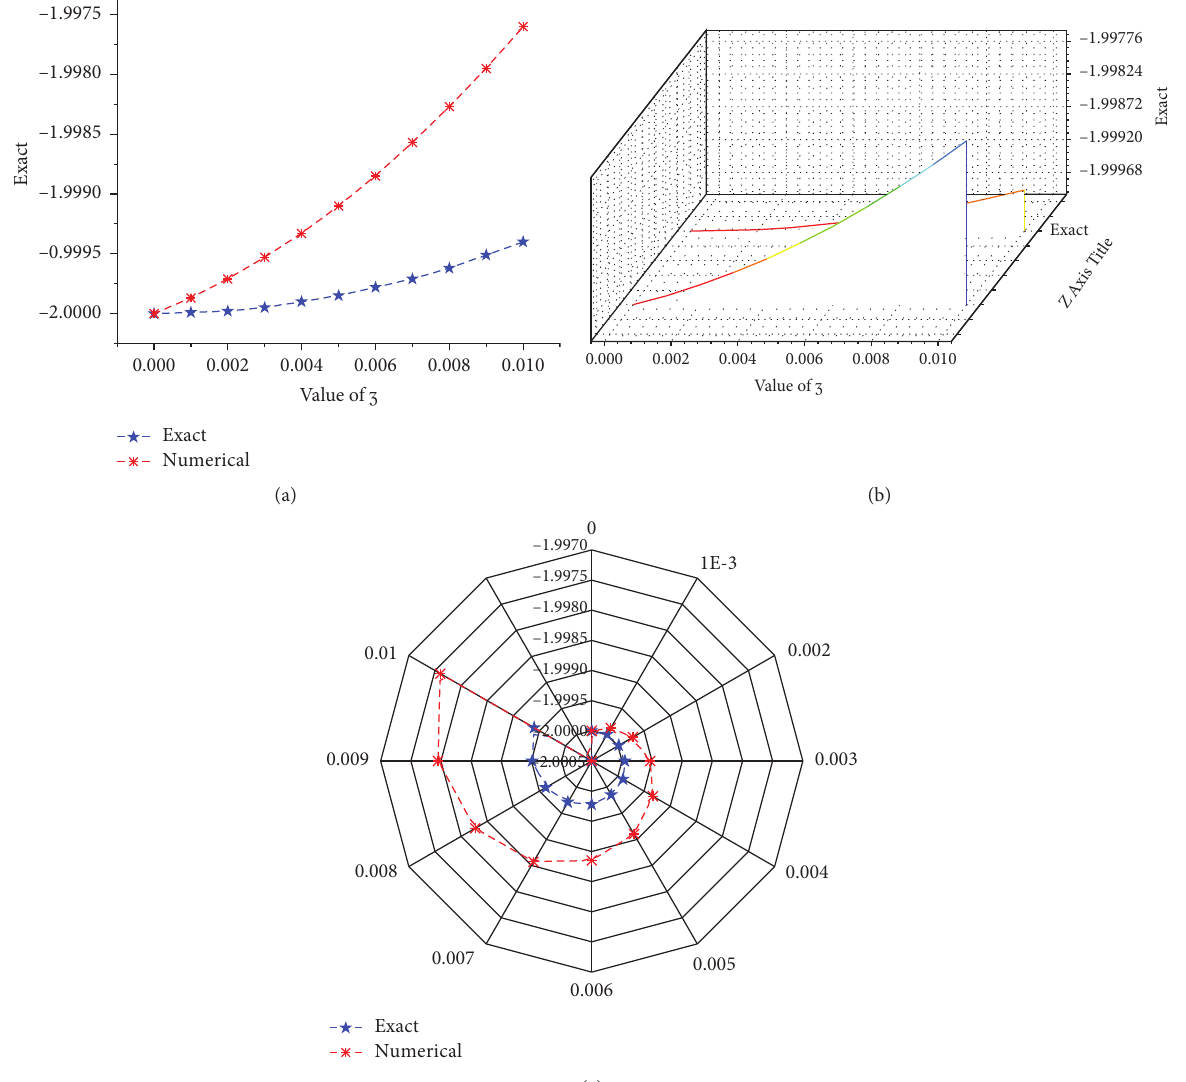
solutions via the extended simplest equation method where the absolute values of error in the sech-tanh method is smaller that those obtained by the extended simplest equation method. Figure 7 explains the absolute value of error in 1 and 2.